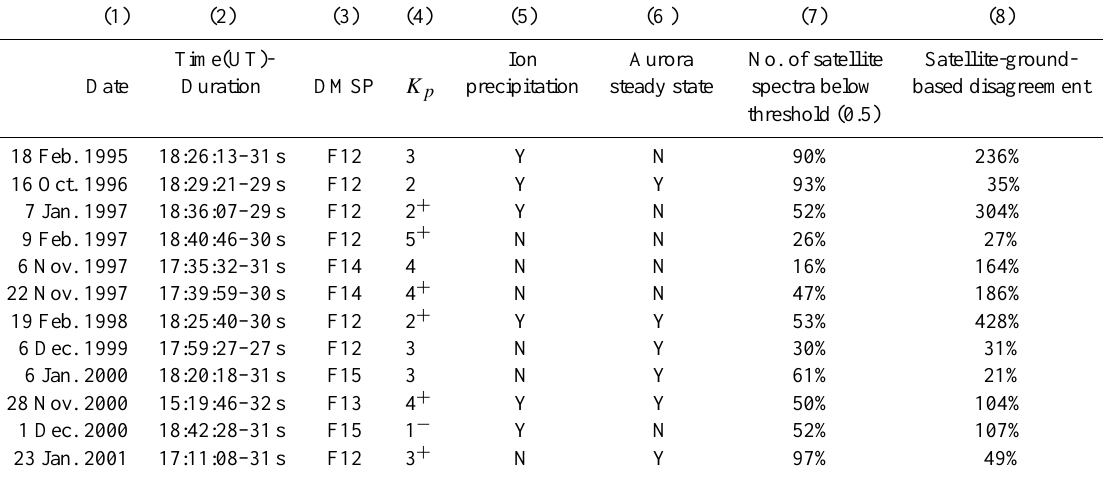
Table 1. DMSP satellite